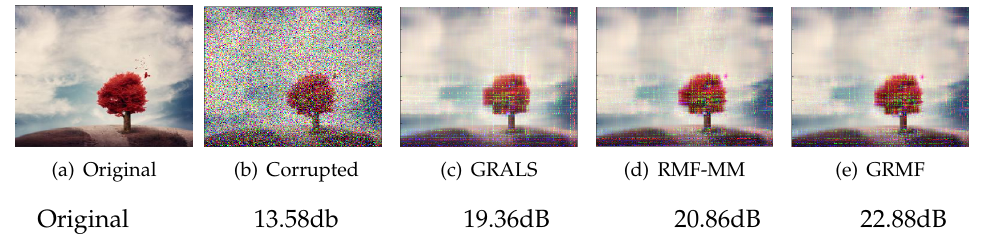
Figure 6. The Results of Image recovery with salt-and-pepper noise.